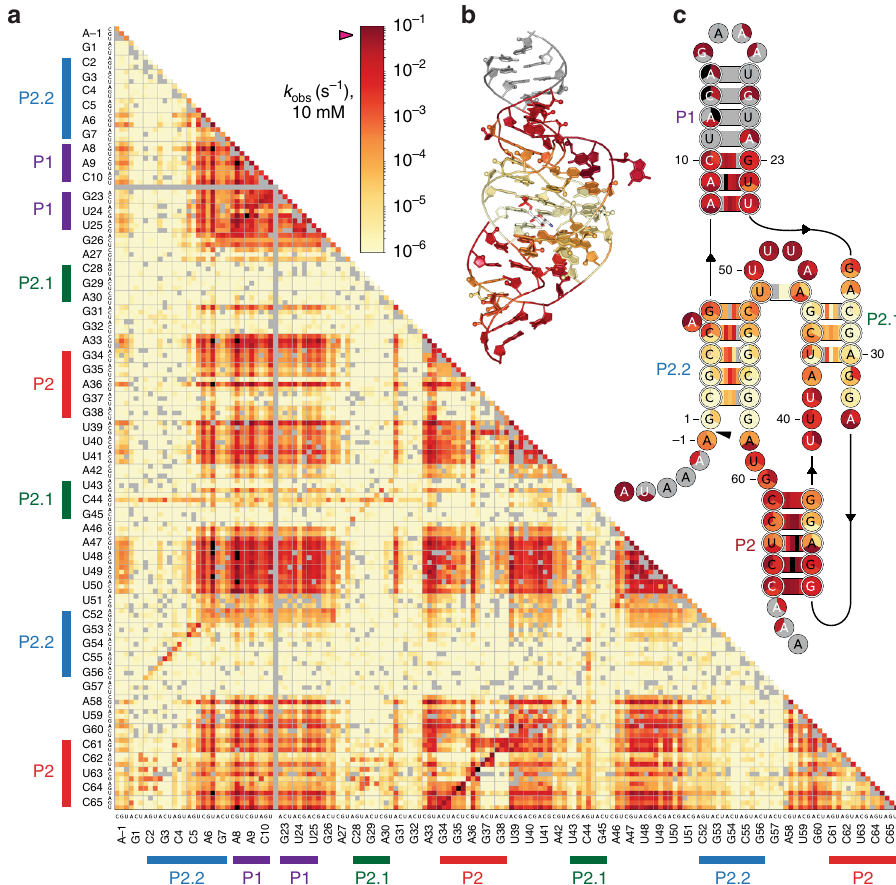
Fig. 4 Effects of mutations on cleavage rate at 10 mM GlcN6P. a Heatmap of rates for all measured single and double mutants, with the fi rst constituent point mutation indicated on the ordinate and the second on the abscissa. Sequence regions participating in duplex structures are labeled and color-coded as in Fig. 1. Heatmap of cleavage rates of all single mutants and basepaired-partner double mutants superimposed on the ribozyme tertiary ( b ) and secondary ( c ) structure, with secondary elements indicated in the same color scheme as a . The structure in b is based on PDB 2Z75. Source data are available in the Source Data fi